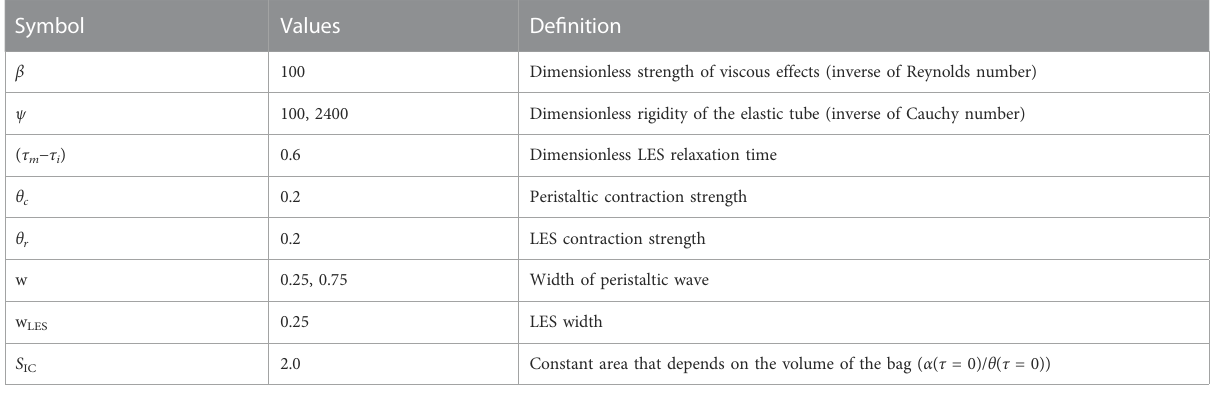
TABLE 1 List of non-dimensional parameters.